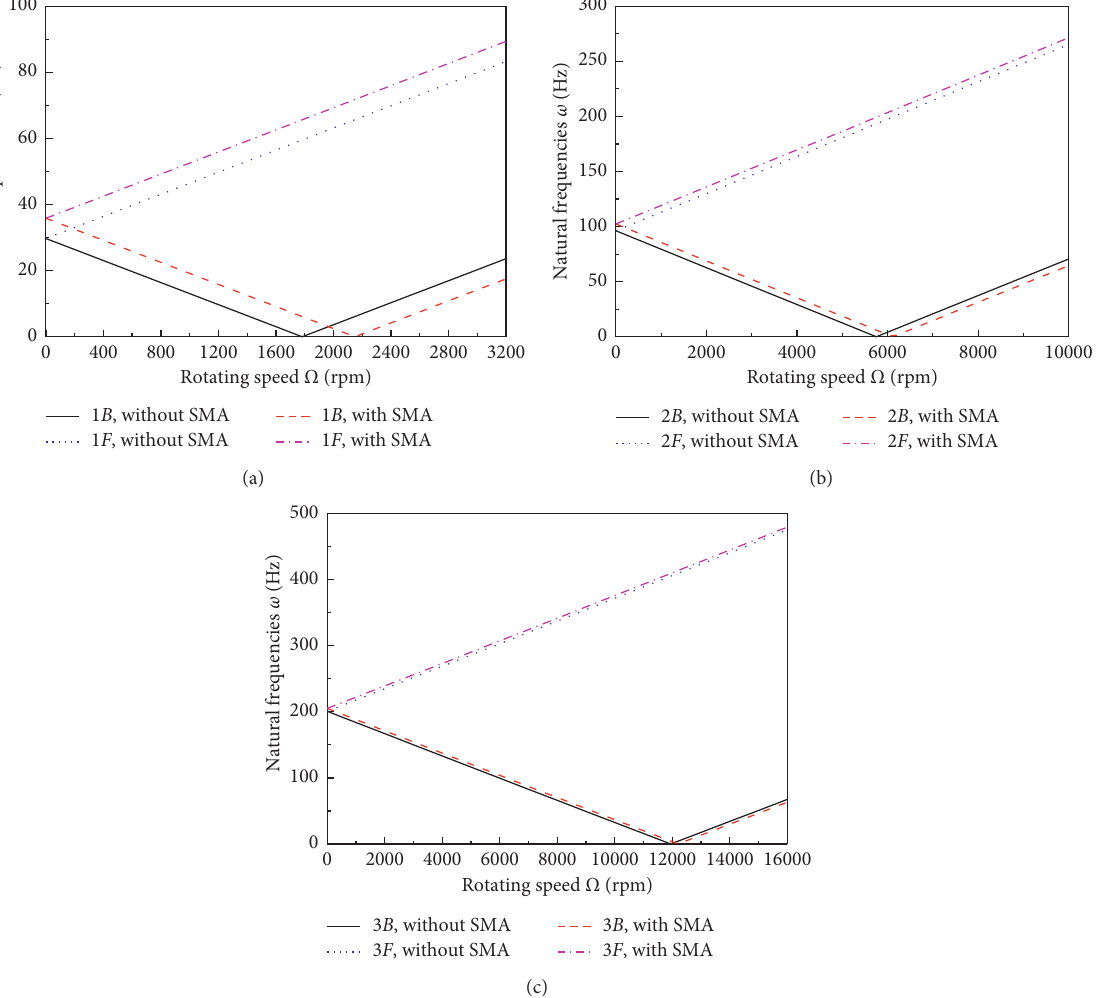
Figure 4: The natural frequencies versus rotating speed of the tapered composite rotating shaft with SMA and without SMA for S-S � 0 . 005): (a) the first mode; (b) the second mode; (c) the third boundary condition ( σ � 0 . 5 , θ � 30 ° ,Vs � 0 . 1 ,T � 50 ° C , ε 0